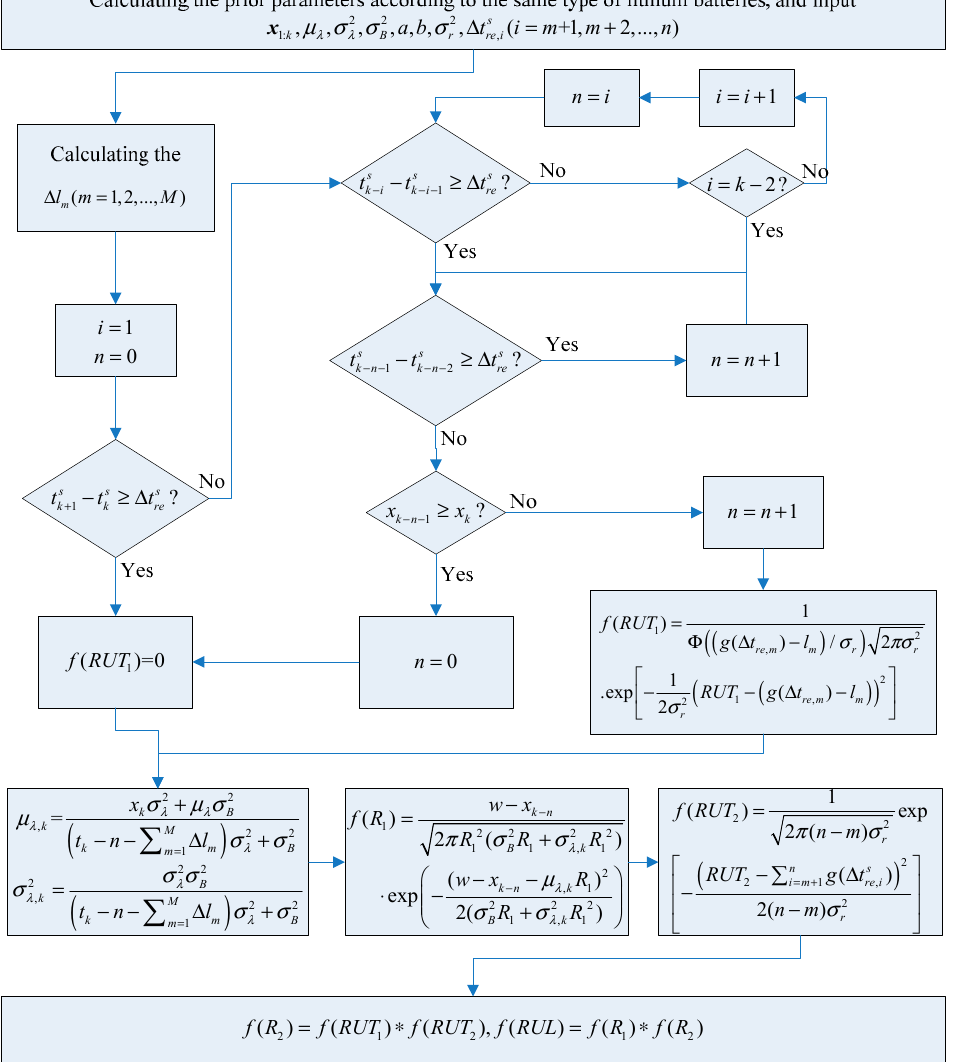
Figure 6. The algorithm flow chart for RUL prediction with considering the relaxation effect.